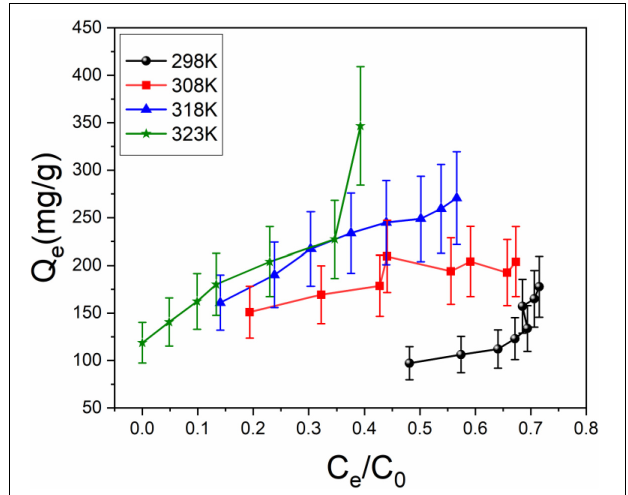
FIGURE 7 | Adsorption isotherms of TiO 2 /Ti for uranium (VI) at different temperatures (temperature 298–323 K, pH 5.0, amount of TiO 2 /Ti 0.025 g, and mixing time 60